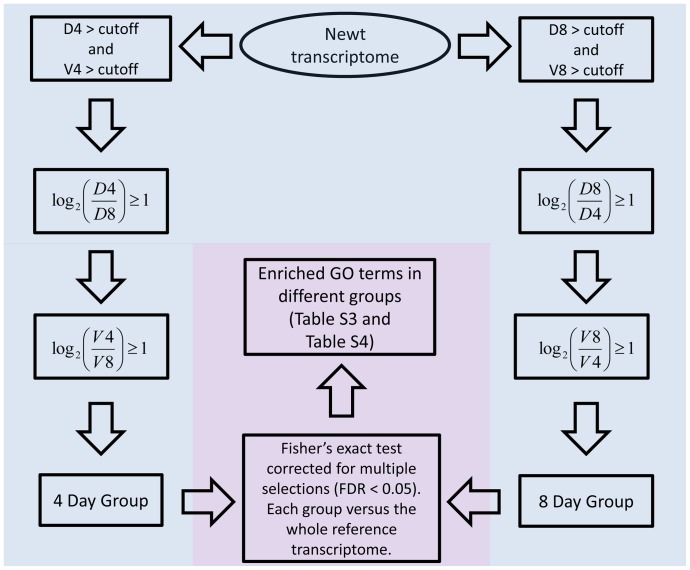
Workflow used to select transcripts for comparison of gene expression 4 and 8 days post-lentectomy.Only transcripts expressed above the cutoff (see methods) in the day of interest and up-regulated more than 2-fold in both dorsal and ventral iris (light blue) were considered. Fisher’s exact corrected for multiple selections (FDR <0.05) was used to compare the GO of the groups versus the remaining transcripts of the transcriptome. Enriched GO terms were found (light purple).